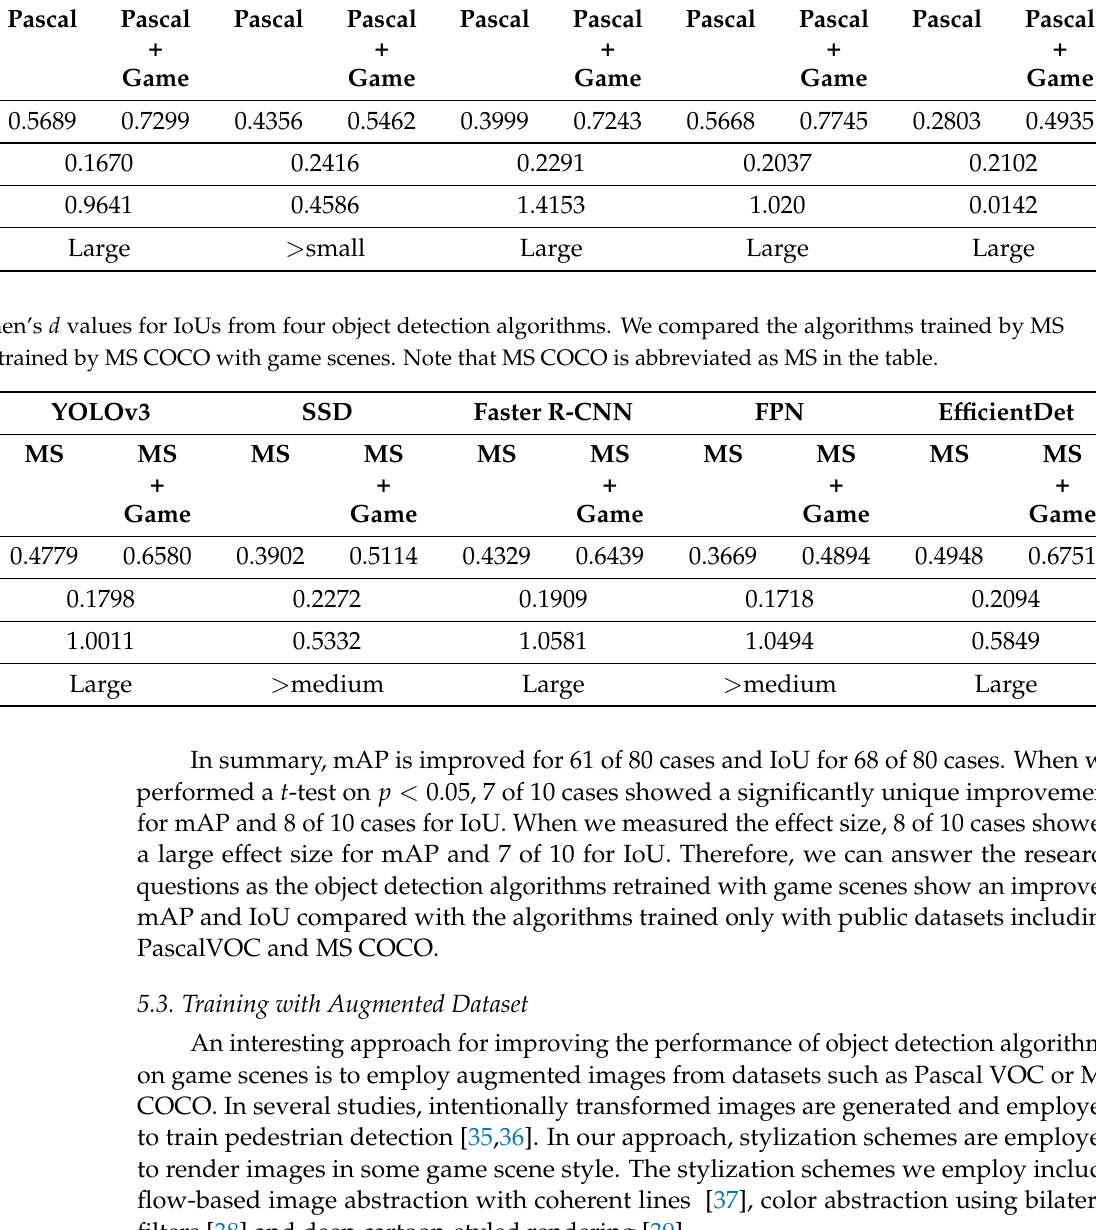
Table 14. Cohen’s d values for IoUs from four object detection algorithms. We compared the algorithms trained by PascalVOC and retrained by PascalVOC with game scenes. Note that PascalVOC is abbreviated as Pascal in the table. Algorithm